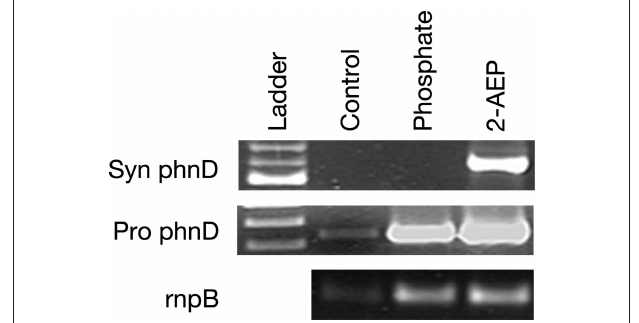
FIgure 4 | rT-PCr from the growout experiment rNA extracted in 48 h after the addition of nutrients. Control – no amendments, Phosphate – addition of 0.5 μM of phosphate, and 2-AEP – addition of 500 nM of 2-aminoethylphosphonate. Top row, Synechococcus phnD expression; middle row, Prochlorococcus phnD expression; bottom row, rnpB